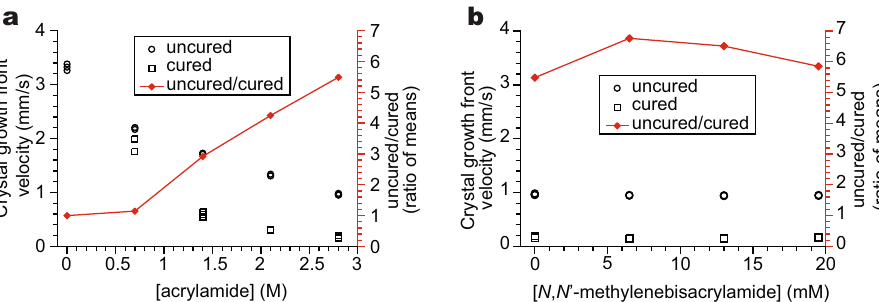
Fig. 2 Comparison of linear growth rates of sodium acetate trihydrate crystals in samples containing 7.0 M sodium acetate and various polymerized and unpolymerized additive compositions. N = 3 for all points except 2.8 M acrylamide without cross-linker in both graphs, where N = 6. Crystallizing samples were placed on a cold plate held at 20 °C. Uncured/cured ratios are ratios of mean velocities. a Comparison of growth rates through polymerized and unpolymerized solutions containing different concentrations of acrylamide without a cross-linker. b Comparison of growth rates through polymerized and unpolymerized solutions containing 2.8 M acrylamide and various concentrations of N,N ′ -methylenebisacrylamide